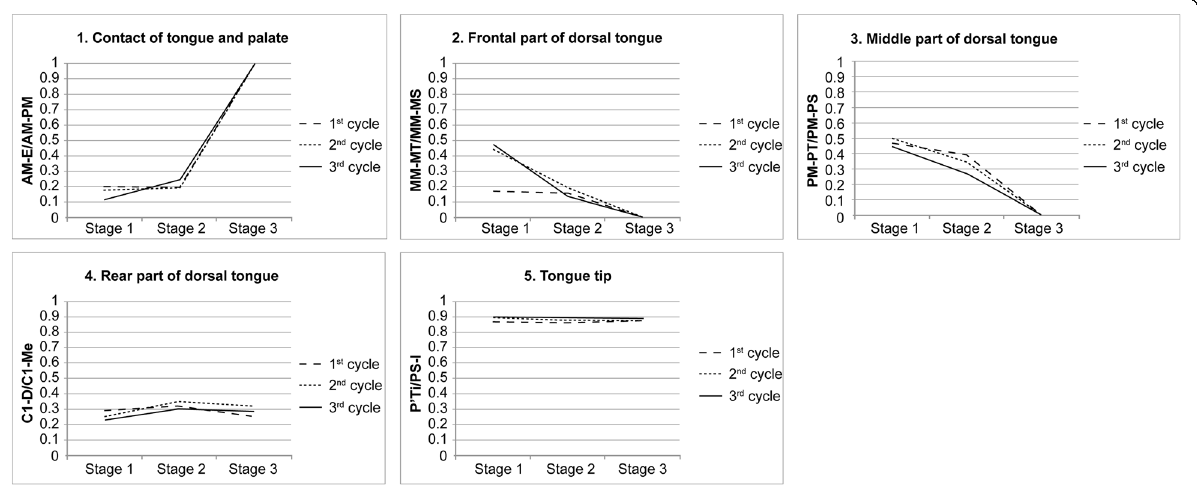
Fig. 8 Comparison of linear measurements recorded in each cycle of deglutition in a representative subject. For abbreviations, see Table 1. Linear measurements are as described in Fig.